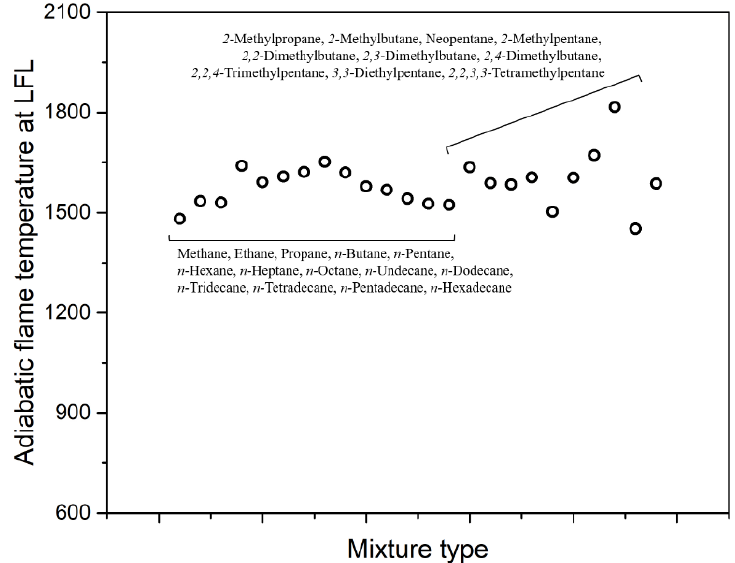
Figure 16. Calculated adiabatic flame temperature for paraffinic hydrocarbons by Vidal et al.’s